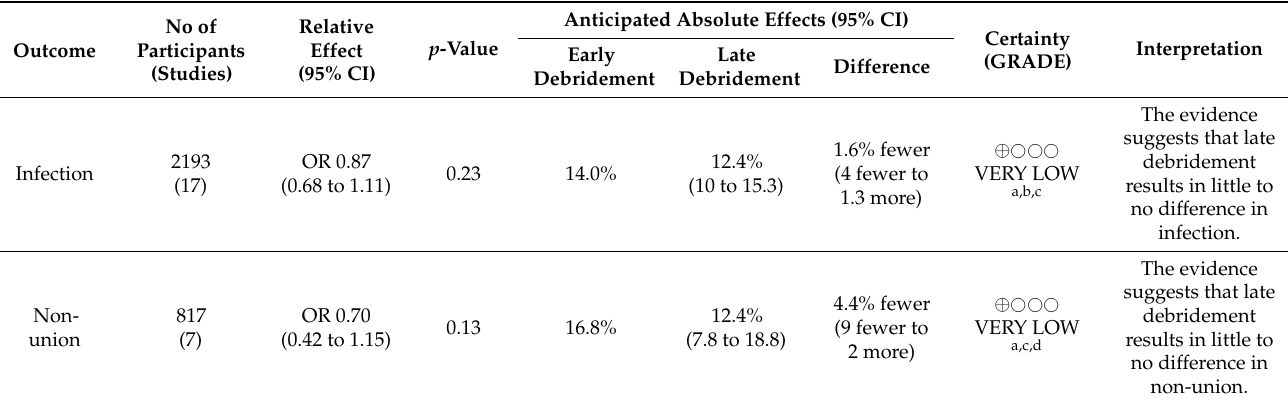
Table 2. Summary of findings table for primary outcomes (infection and non-union) with relative and anticipated absolute effects, GRADE quality of evidence assessment and evidence